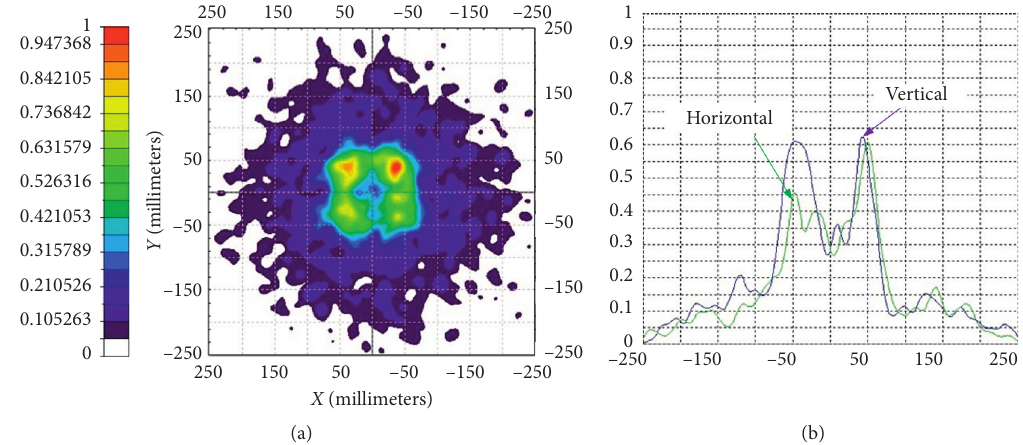
Figure 7: Total-irradiance map diagram of the receiving surface of the compound eye plano-convex lens with 97 monocular lenses and sunflower-shaped plano-convex lens array.